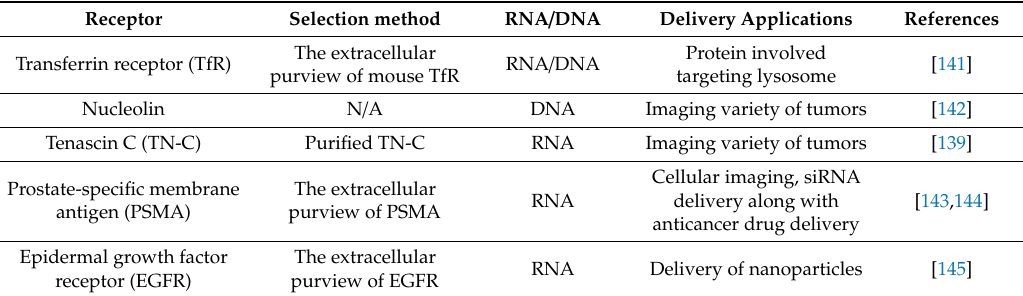
Table 6. Aptamers based on cell surface protein along with their delivery